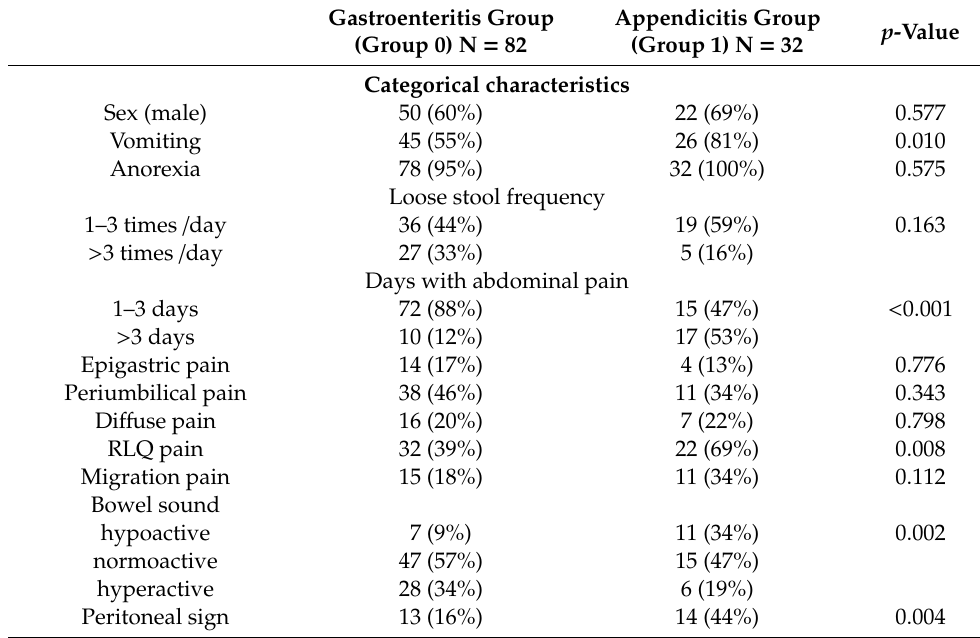
Demographics, characteristics, and outcome in the appendicitis group and the enterocolitis